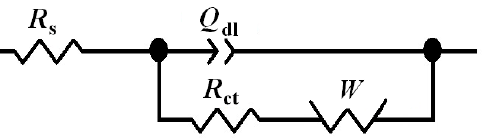
Figure 5. Equivalent electrical circuit employed to fit the electrochemical impedance spectroscopy (EIS) spectra.